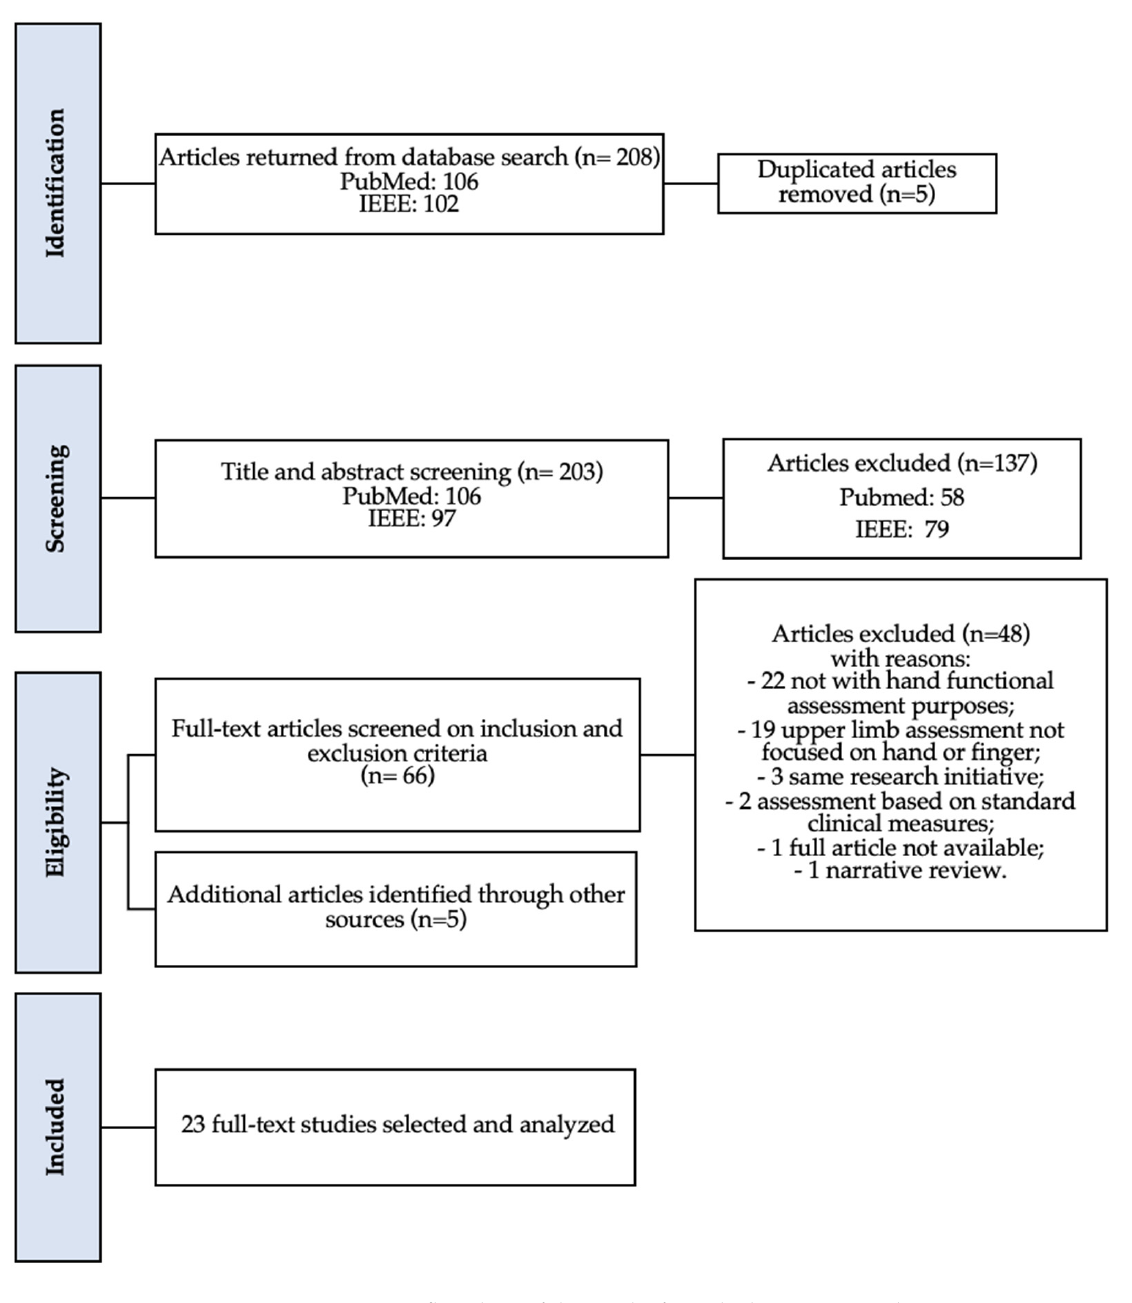
Figure 1. PRISMA flowchart of the results from the literature search.